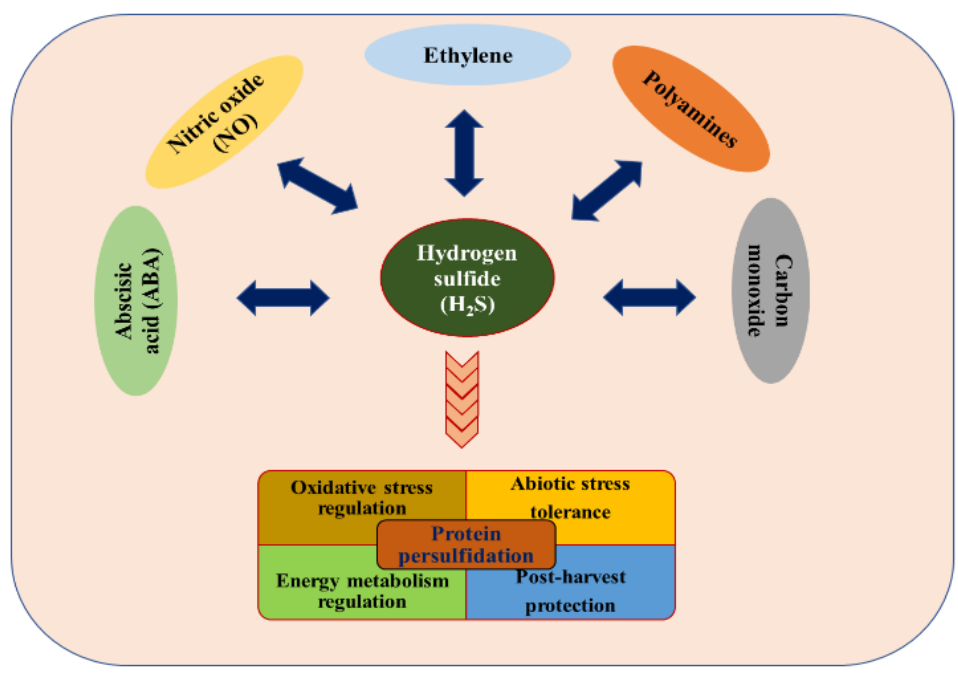
Figure 1. Role of hydrogen sulfide in mediating the different physiological processes in plants by undergoing interaction with plant hormones and other gasotransmitters.